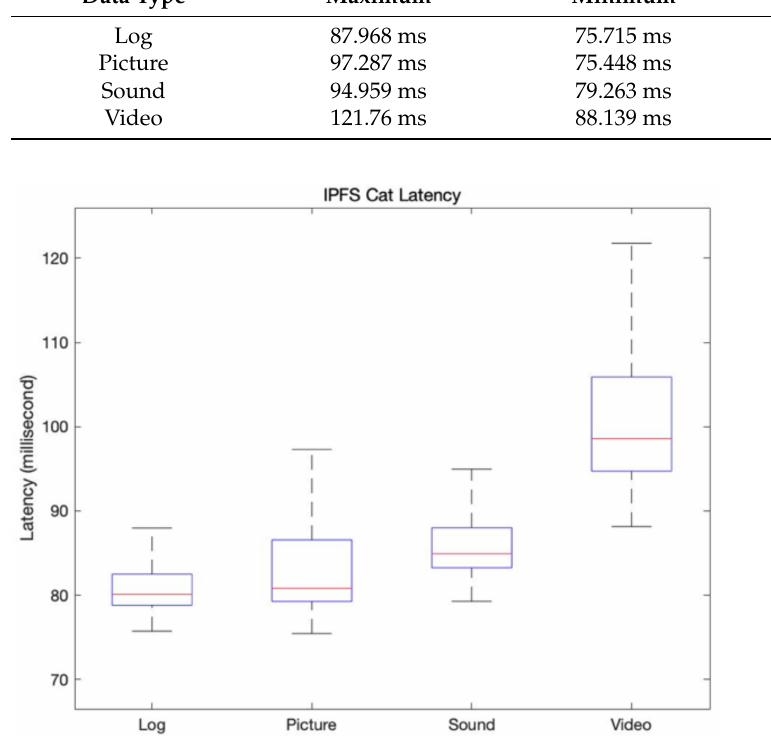
Figure 11. IPFS Cat Latency.